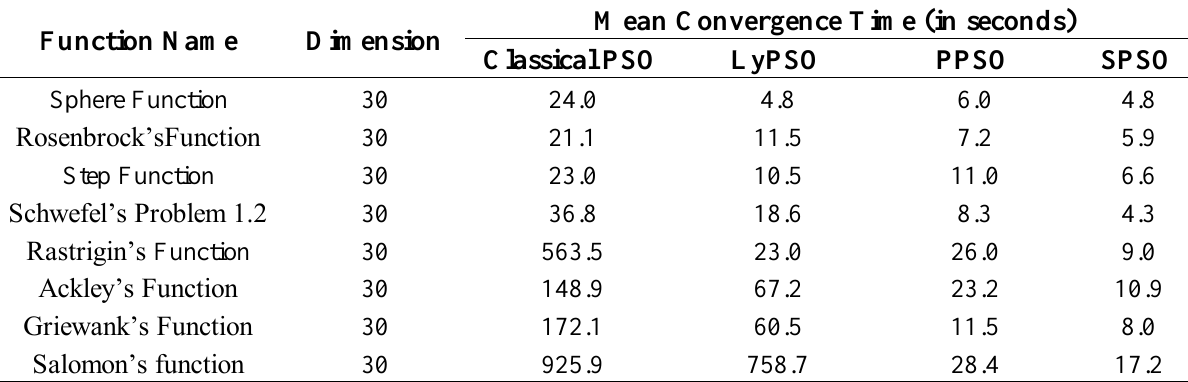
Table 8. Mean convergence time of the benchmarks over